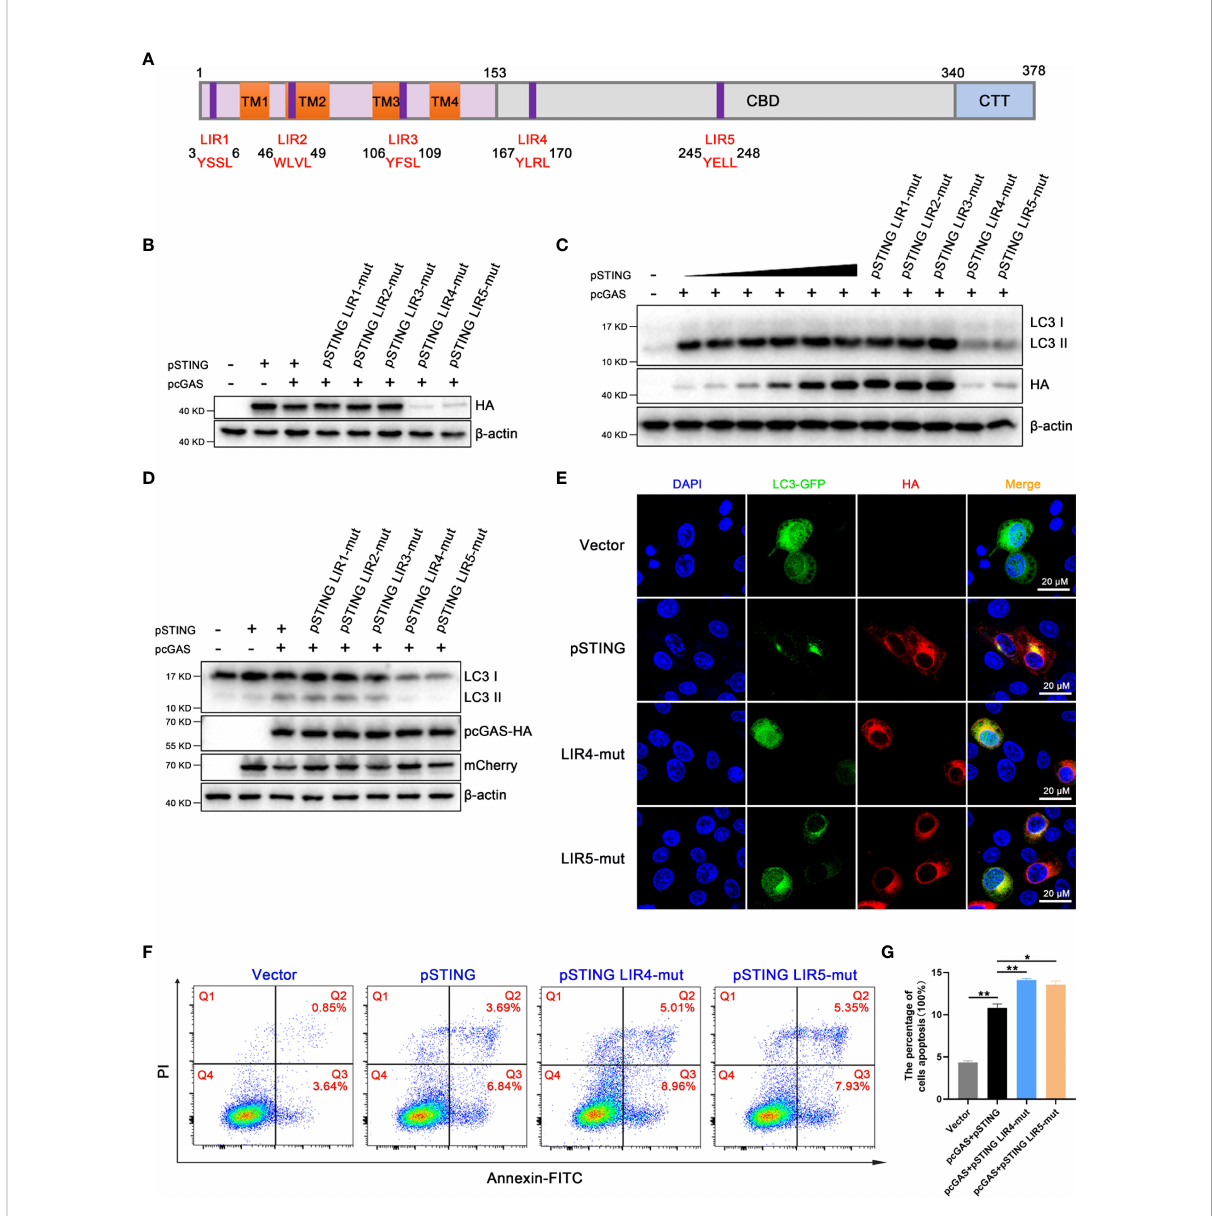
FIGURE 8 LIRs as important motifs participate in STING mediated autophagy regulation. (A) Graphical representation of the pSTING showing the fi ve potential LIR motifs. The N-terminal domain contains 4 transmembrane regions (TM1-4), the CBD is c-di-GMP binding domain, and the C- terminal tail (CTT) contains the cytoplasmic tail. The amino acid sequences of the predicted LIR motifs are indicated. (B) 293T cells were transfected with pcDNA-pSTING-2HA or corresponding LIR mutants (1 m g each) for 24 h, followed by Western blotting. (C) 293T cells were co- transfected with pcDNA-pcGAS-2HA (0.5 m g) and pcDNA-pSTING-2HA (0, 0.05, 0.1, 0.2, 0.3, 0.4, 0.5 m g) or corresponding LIR mutants (each 0.5 m g) for 24 h, followed by Western blotting. (D) 293T cells were co-transfected with pcDNA-pcGAS-2HA (0.5 m g) plus pmCherry-C1-pSTING or corresponding LIR mutants (0.5 m g) for 24 h, followed by Western blotting. (E) 3D4/21 cells were co-transfected with LC3-GFP (0.5 m g) and pSTING-2HA or LIR4-mut or LIR5-mut (0.5 m g each) for 24 h. Images of LC3 and pSTING were then captured by confocal microscopy. Scale bar: 20 m m. (F, G) 293T cells were co-transfected with pcGAS-HA (0.5 m g) plus pSTING-HA (0.05 m g), LIR4-mut or LIR5-mut (0.5 m g) for 24 h, and the Annexin V positive cells were detected by fl ow cytometry. * p < 0.05 and ** p <